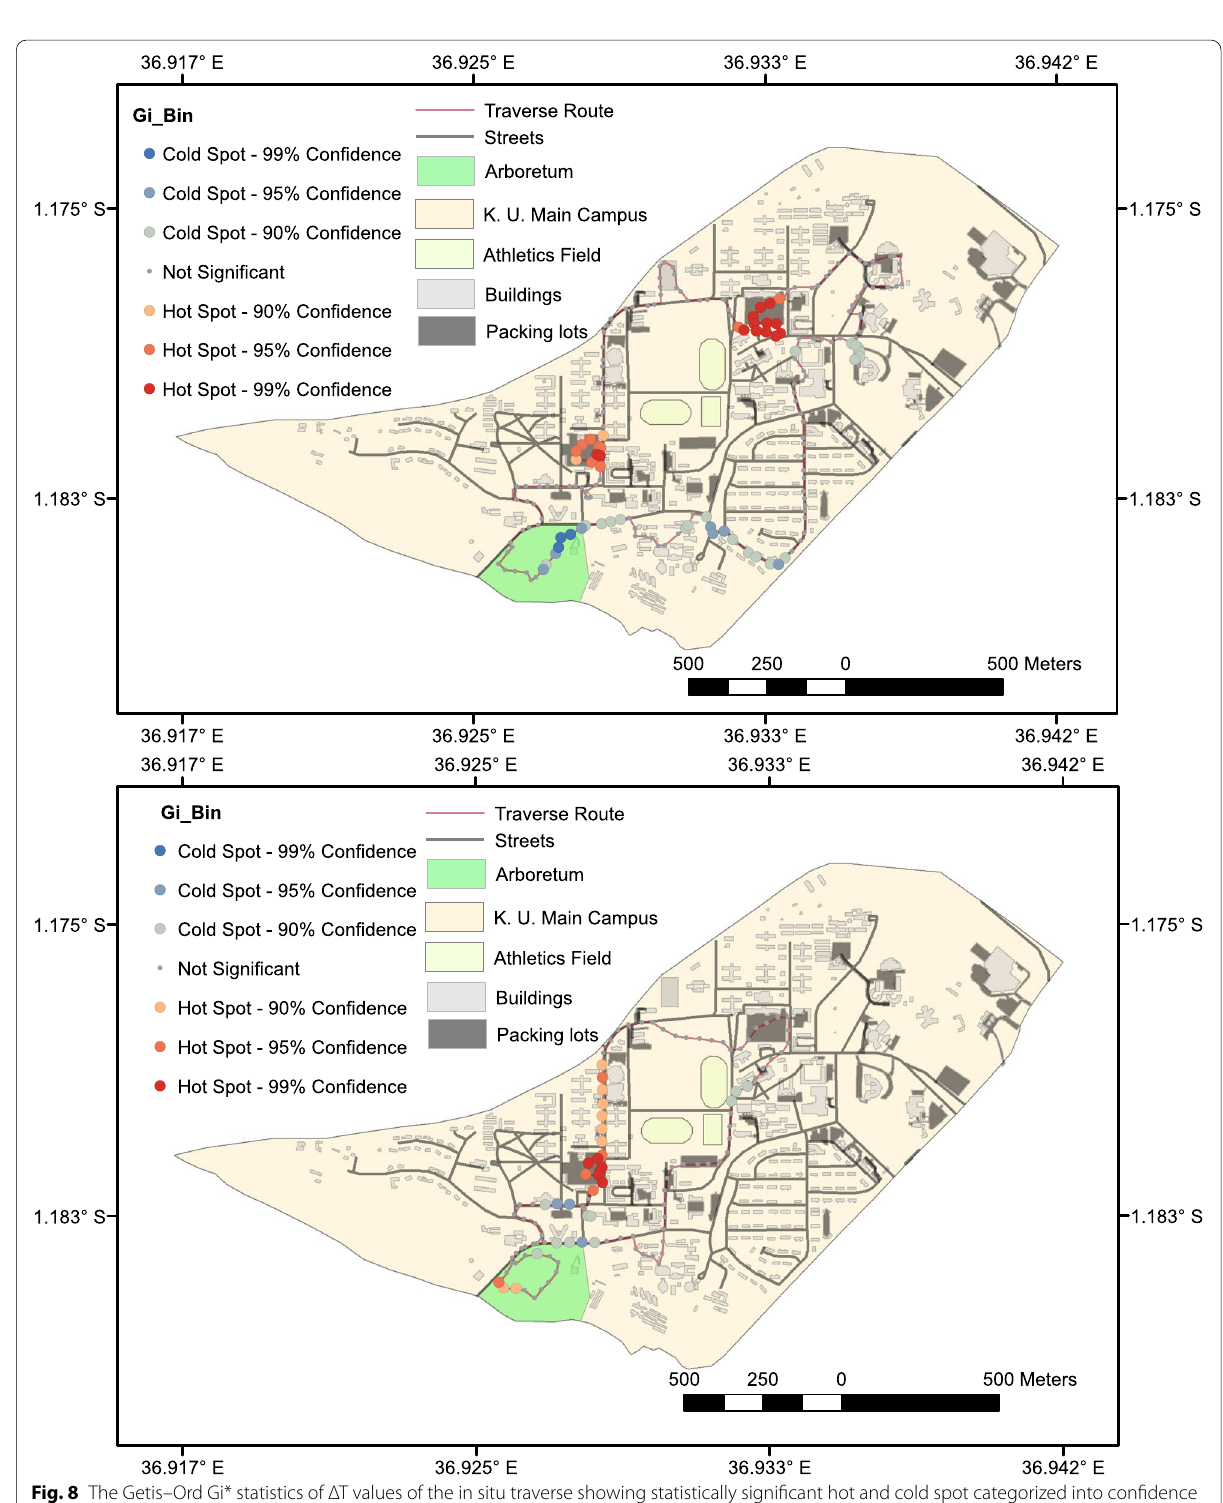
Fig. 8 The Getis–Ord Gi* statistics of ΔT values of the in situ traverse showing statistically significant hot and cold spot categorized into confidence level bin in 3 bins, 2 bins, and 1 bins corresponding to 99 percent, 95 percent, and 90 percent confidence level (Gi_Bin). The cold spots and ± ± ± hot spots for the late afternoon traverse walk (8 th January 2018 ) and morning traverse walk (18 th February 2021) is shown on the top and bottom map